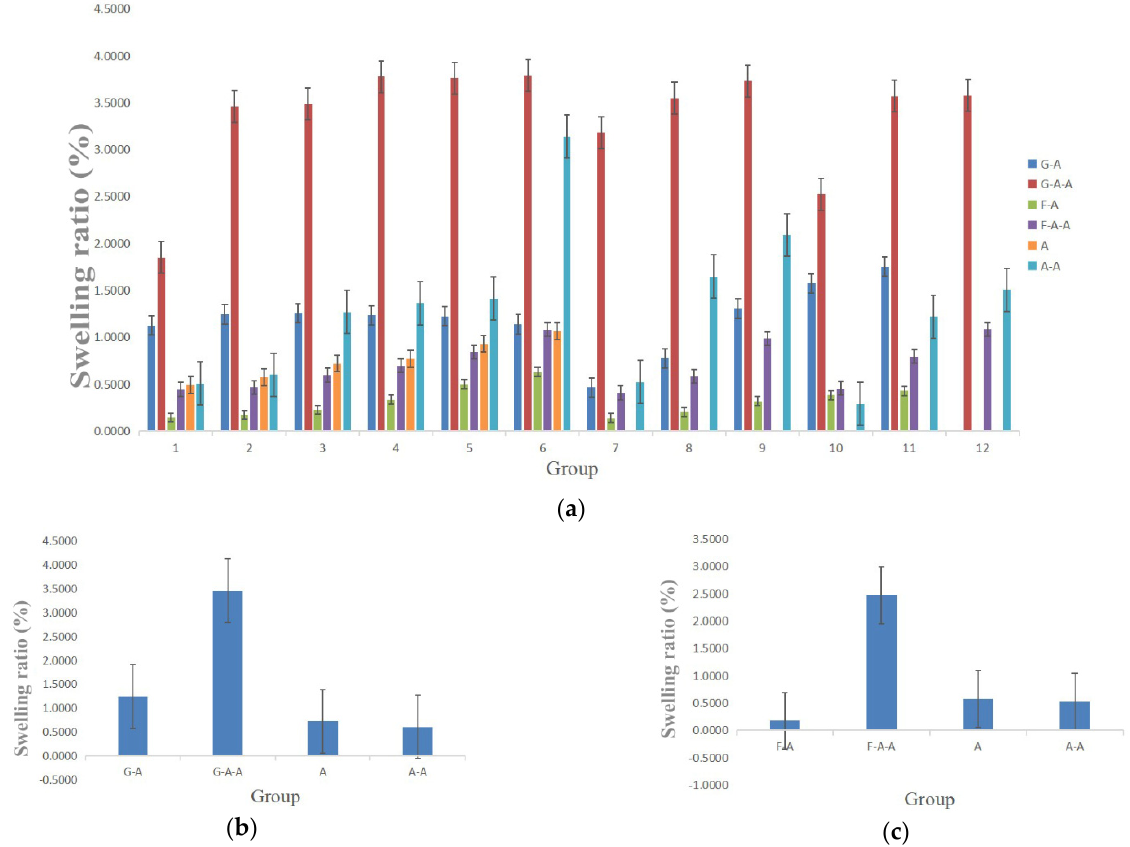
Figure 4. Swelling ratio of the alginate-based hydrogels: ( a ) comparison of the swelling rates of the G-A, F-A, A-A, G-A-A, F-A-A and A hydrogels prepared in Table 1; ( b ) comparison of the swelling rates of the G-A, G-A-A, A and A-A hydrogels prepared in Table 2; ( c ) comparison of the swelling rates of the F-A, F-A-A, A and A-A hydrogels prepared in Table